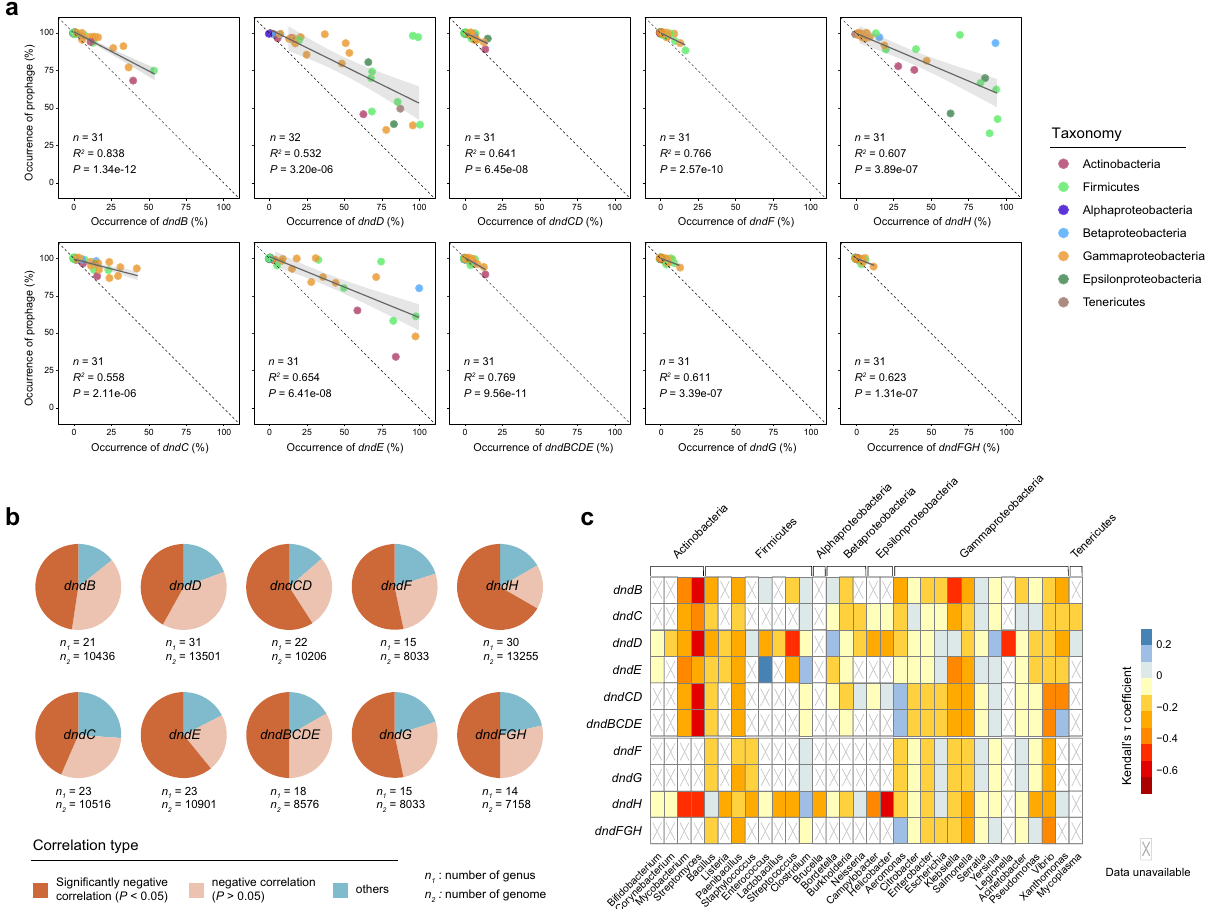
Fig. 3 Negative correlations between the occurrence of dnd genes/gene clusters and prophages are predominant in bacteria. a Correlation analysis between the occurrence of dnd genes/gene clusters and prophages among different genera. The black solid line in each sub-plot refers to the best fi tting, and the gray shadow displays the 95% con fi dence interval from linear regressions. The dashed lines depict the 1:1 linear relationship. The number of analyzed genera ( n ), R 2 values and P values of linear regressions are shown in each sub-plot. Each circle represents a single genus, and is depicted in the color representing the taxonomy at the phylum and class levels (for Proteobacteria). b , c Correlation analysis between the occurrence of dnd genes/gene clusters and prophages in thoroughly sequenced bacterial genera (with ≥ 100 genomes). The correlation type is identi fi ed based on Kendall ’ s τ coef fi cient and signi fi cance values. n 1 and n 2 below each pie chart b refer to the number of genera and included genomes, respectively. The heatmap c shows Kendall ’ s τ coef fi cient, and the crosses indicate statistical unachievability due to a small sample size (number of genomes <30) or the complete absence of dnd genes/gene clusters or prophages in the corresponding genus. The taxonomy of the genera and phyla/classes are shown below and above the heatmap, respectively. Source data are provided as a Source Data fi